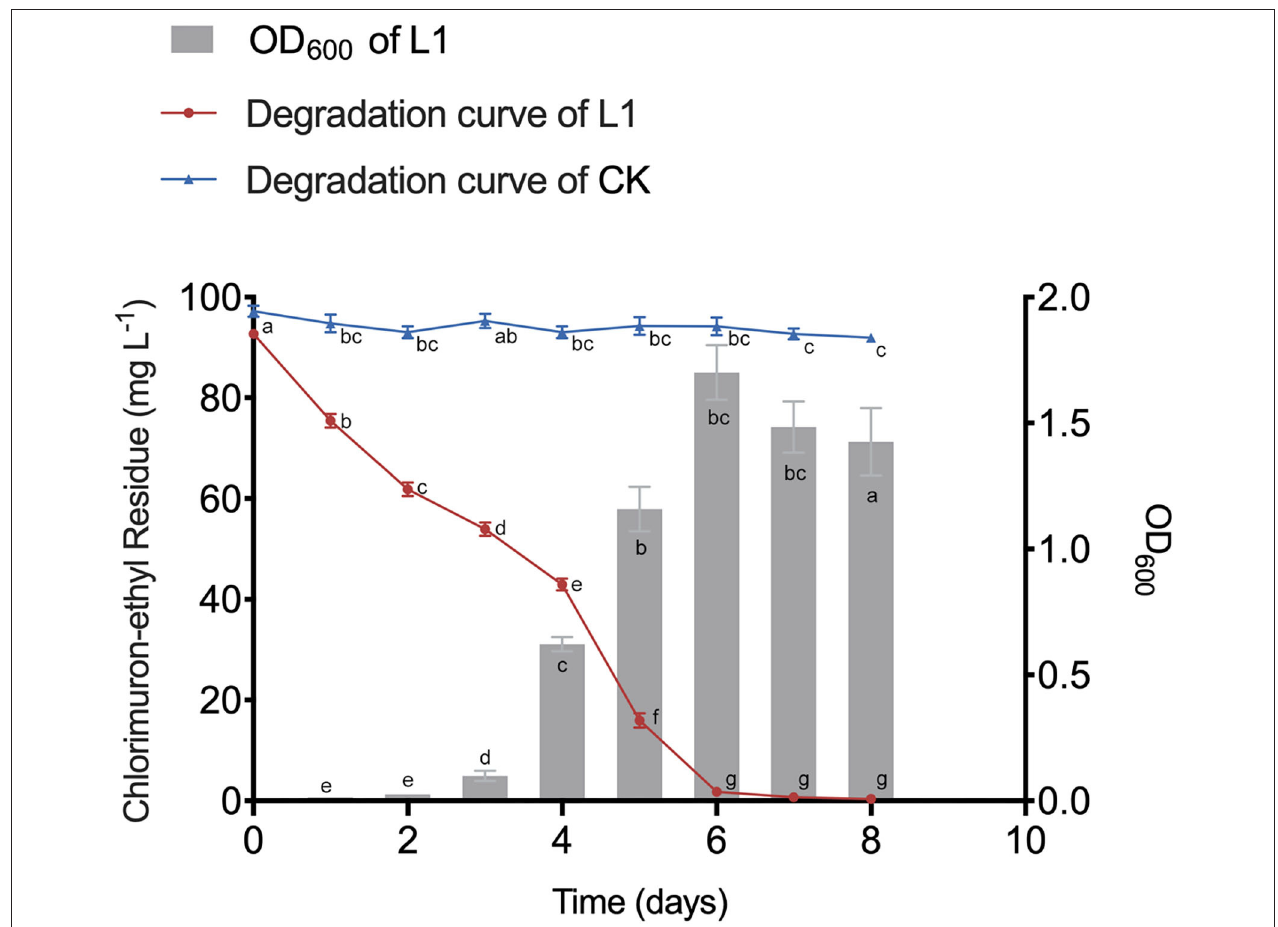
FIGURE 1 | Growth dynamics of microbial consortia L1 (MC-L1) and its degradation curve to